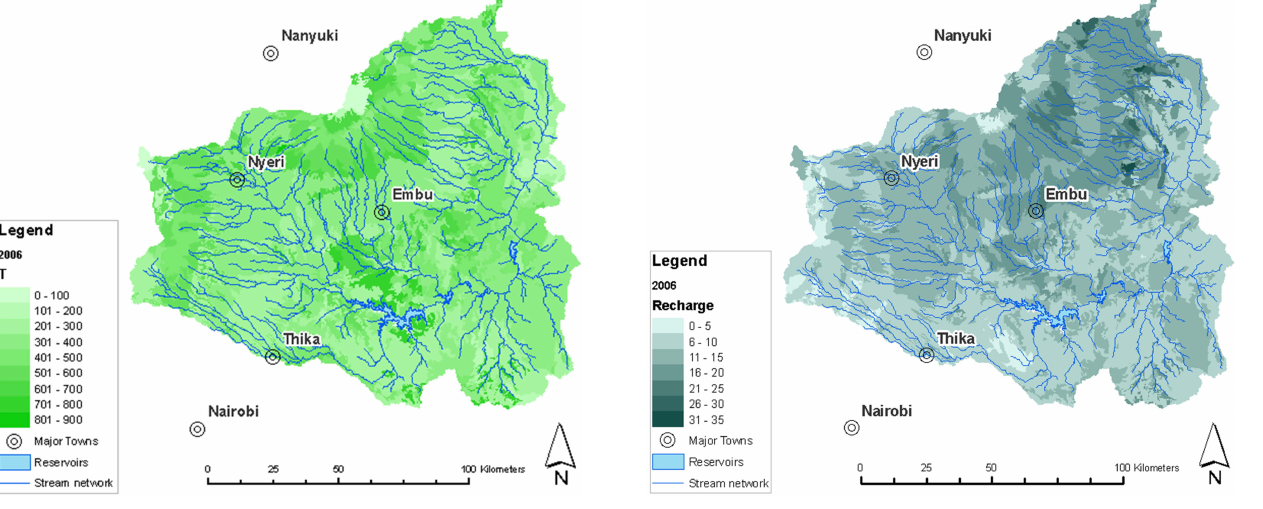
Fig. 4. Actual transpiration in Upper Tana, Kenya (mm per year). Fig. 5. Groundwater recharge in Upper Tana, Kenya (mm per year).